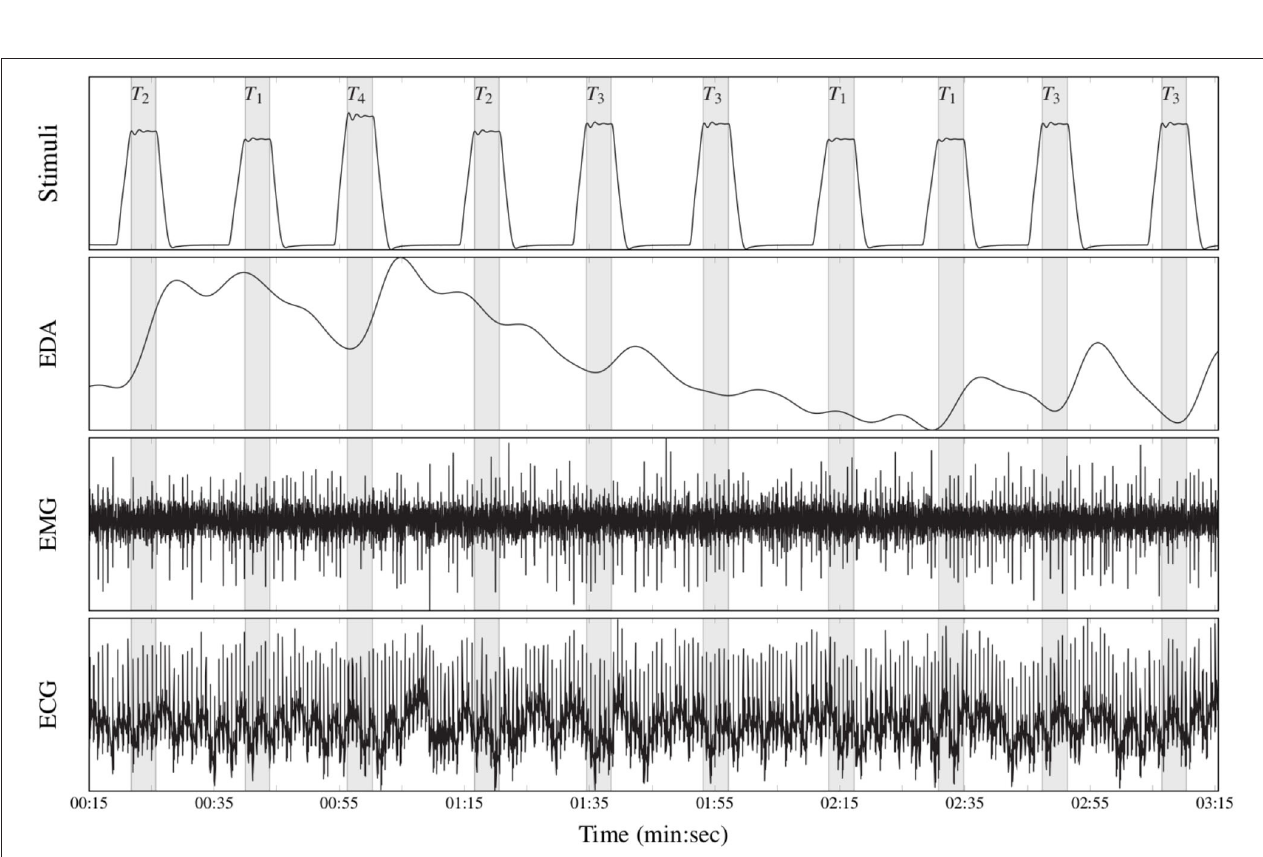
FIGURE 5 | Recorded physiological data (BioVid Heat Pain Database, thermal pain elicitation). From top to bottom: stimuli ( T 1 : pain threshold temperature, T 2 : first intermediate elicitation temperature, T 3 : second intermediate elicitation temperature, T 4 : pain tolerance temperature); EDA ( µ S); EMG ( µ V); ECG ( µ V).